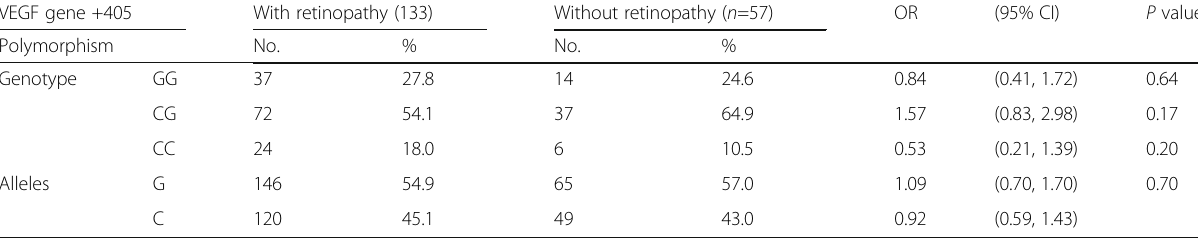
Table 4 Genotype and allele frequency of +405 G/C VEGF polymorphism in patients with and without DR VEGF gene +405